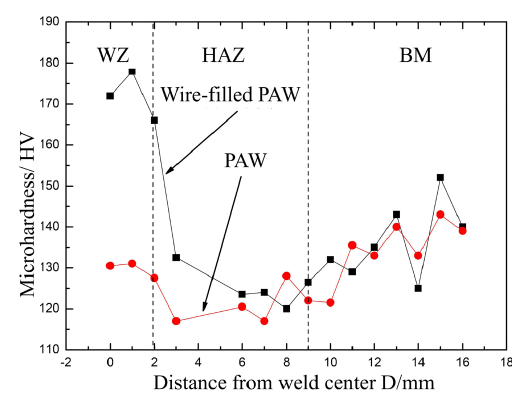
Figure 9. Microhardness distribution curve of welded